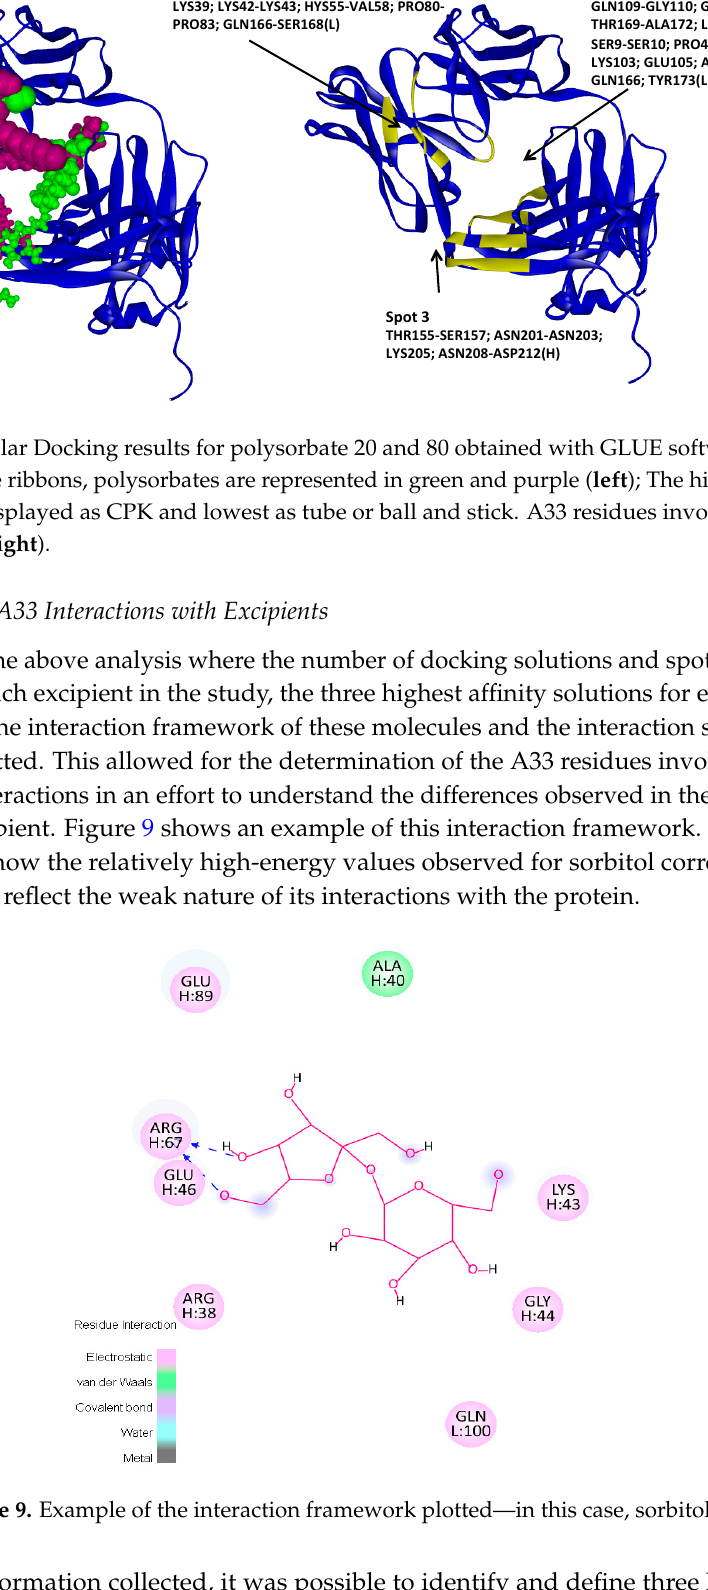
Figure 9. Example of the interaction framework plotted—in this case, sorbitol.